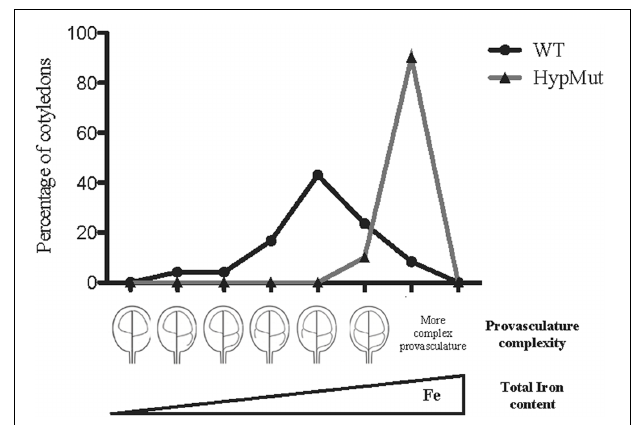
FIGURE 3 | Hypothetic model indicating that Fe total content in seeds will increase in a population of embryos with maximal provasculature complexity. WT data is from Roschzttardtz et al. (2014). HypMut correspond to a hypothetical seed population containing cotyledons with higher provasculature complexity.